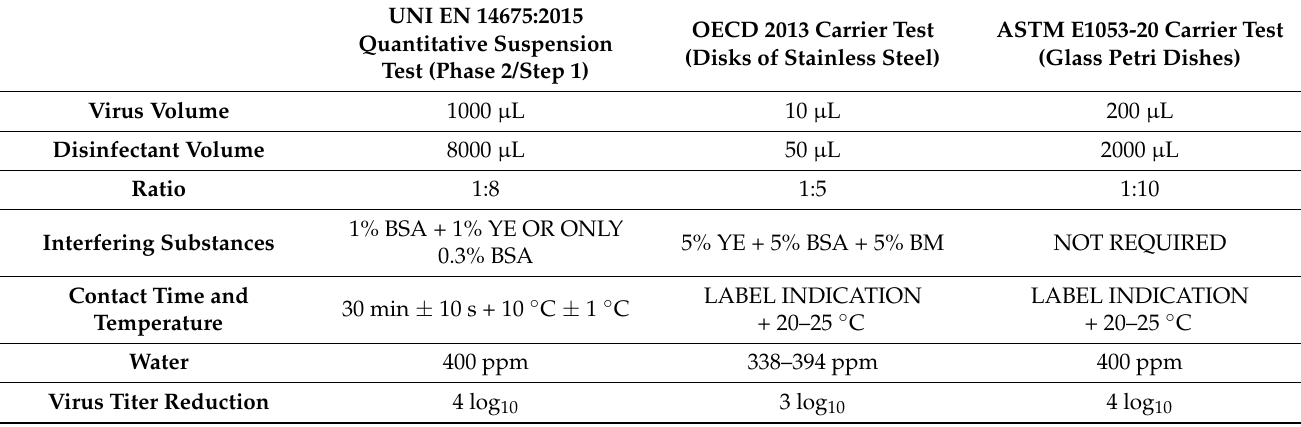
Table 1. Comparison of conditions of the international standards and guidelines adopted to test the virucidal activity of chemical compounds against